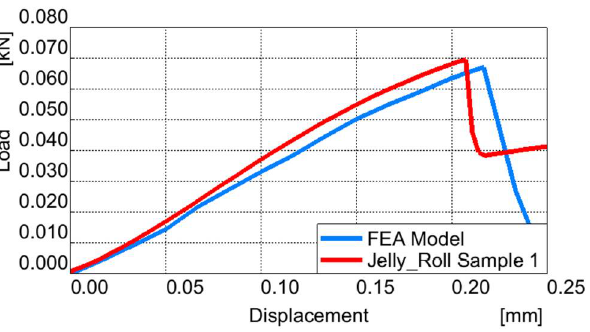
Figure 7. Load-displacement curve for FE model and experimental specimen.